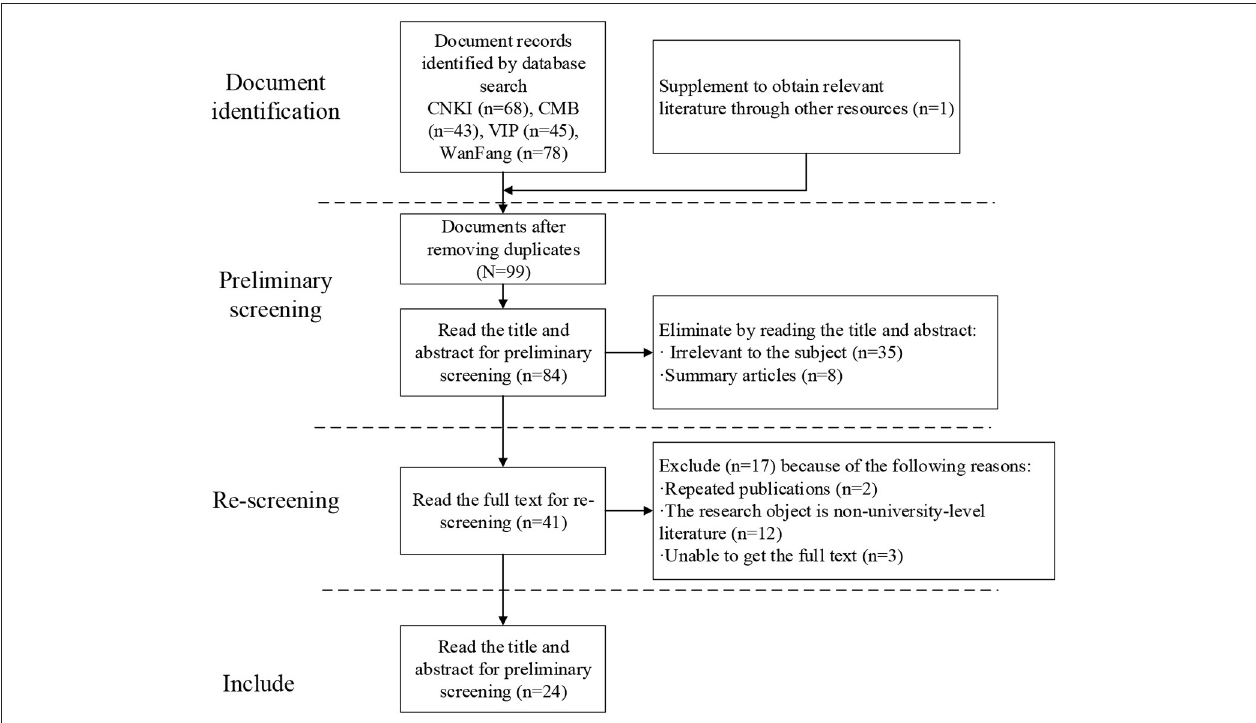
FIGURE 1 | Flowchart of the literature